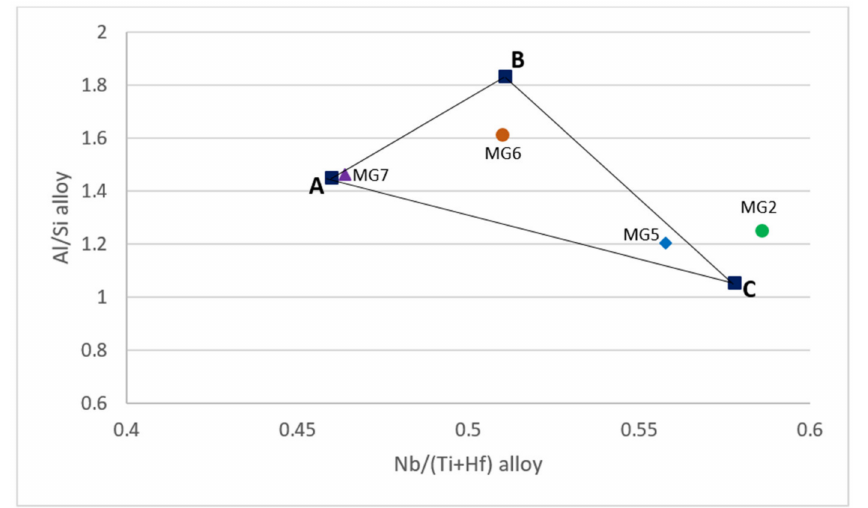
Figure 1. (Al/Si) alloy versus [Nb/(Ti + Hf)] alloy map for Nb-Ti-Si-Al-Hf alloys predicted by NICE [27] to have hexagonal γ Nb 5 Si 3 and no solid solution and weight gains per unit area less than or equal to 1 and 10 mg/cm 2 after 100 h isothermal oxidation respectively at 800 and 1200 ◦ C. The parameters of the alloys Nb 1.7 Si 2.4 Ti 2.4 Al 3 Hf 0.5 (MG2 [3]), Nb 1.45 Si 2.7 Ti 2.25 Al 3.25 Hf 0.35 (MG5), Nb 1.35 Si 2.3 Ti 2.3 Al 3.7 Hf 0.35 (MG6) and Nb 1.3 Si 2.4 Ti 2.4 Al 3.5 Hf 0.4 (MG7 [3]) are shown for their nominal